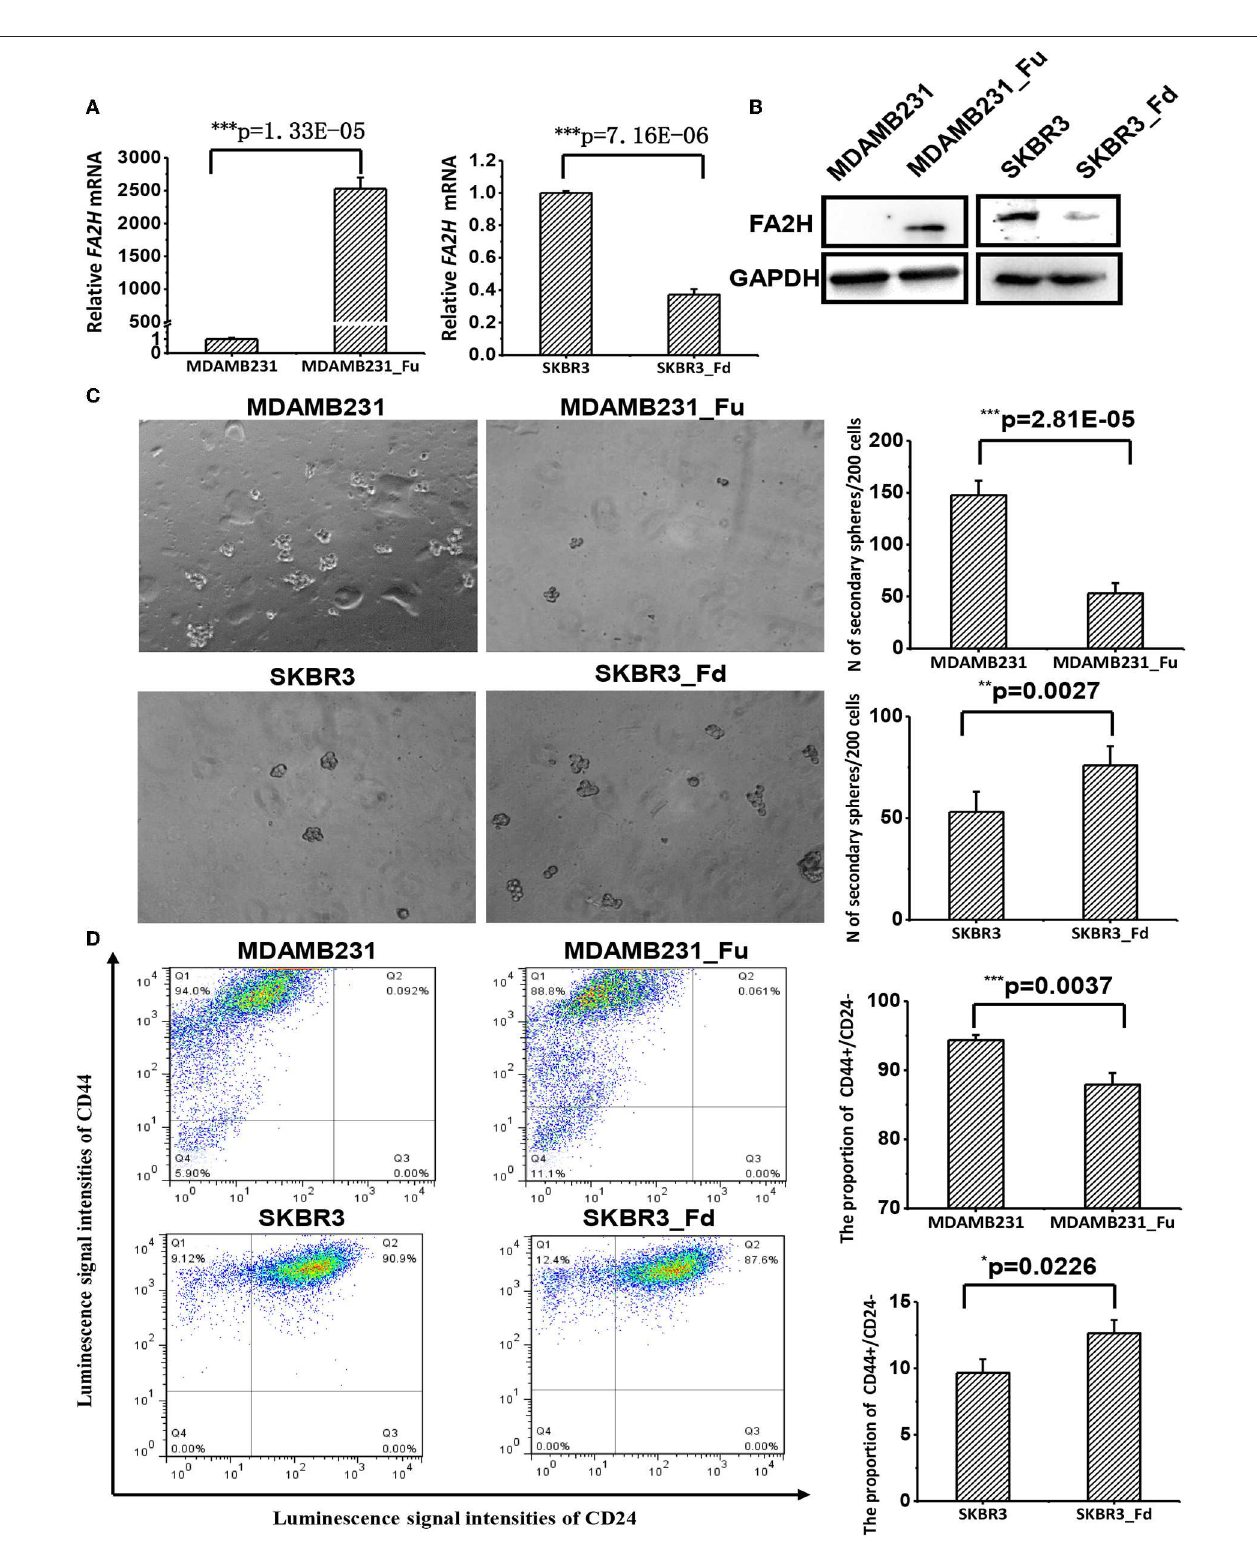
FIGURE 3 | The effects of up- and down-regulating FA2H on breast cancer stemness. (A) FA2H expression in SKBR3_Fd, SKBR3, MDAMB231_Fu, MDAMB231 cells at the gene expression level. (B) FA2H expression in SKBR3_Fd, SKBR3, MDAMB231_Fu, MDAMB231 cells at the protein expression level. (C) Tumorsphere formation of MDAMB231_Fu, MDAMB231, SKBR3_Fd and SKBR3 cells. (D) Cancer stem cell percentage in MDAMB231_Fu, MDAMB231, SKBR3_Fd, and SKBR3 cells according to flow cytometry analysis.